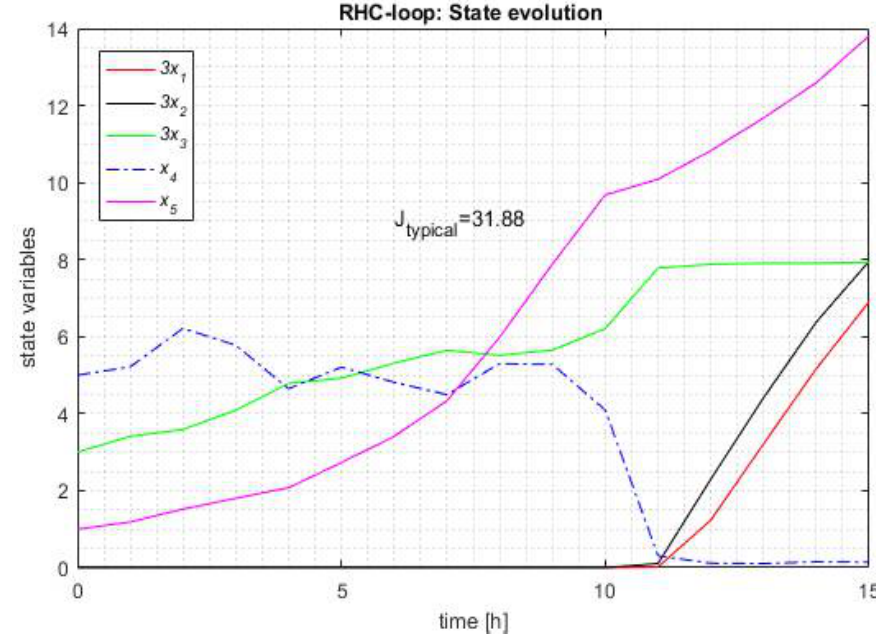
Figure 6. Typical control output—controller with control input range estimation.